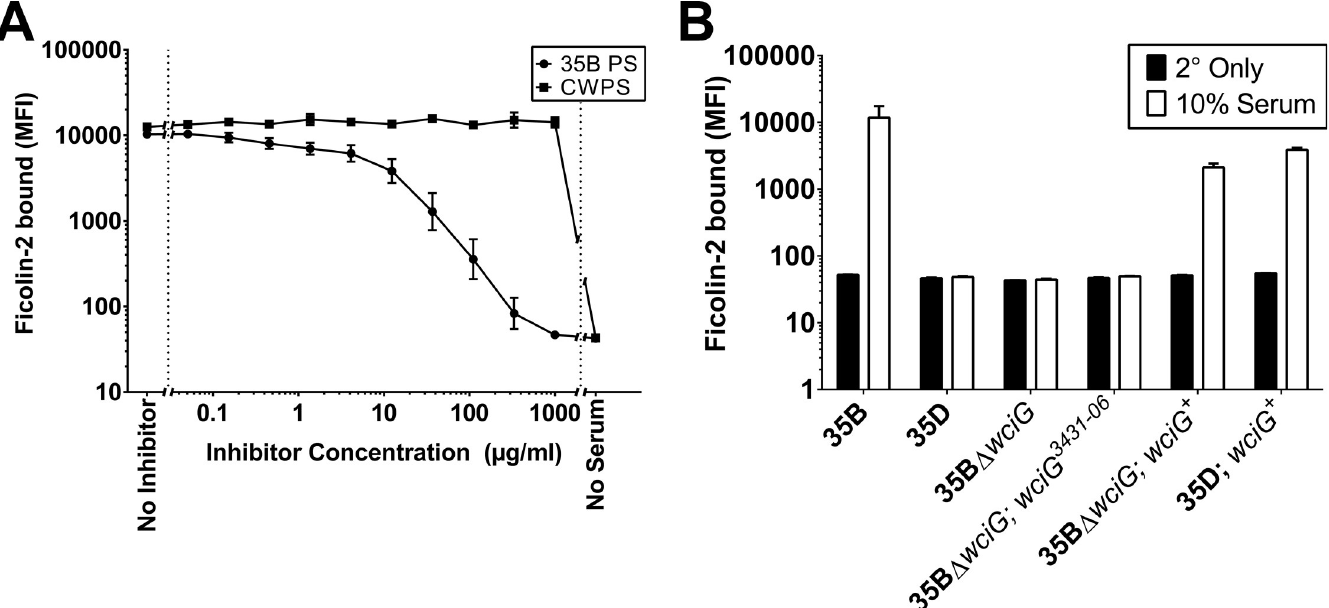
Fig 1. Ficolin-2 binds the serotype 35B capsular polysaccharide in a manner dependent on WciG-mediated O-acetylation. A, Serotype 35B strain 3009–06 was incubated with 10% normal human serum in the presence of increasing amounts of purified serotype 35B capsular polysaccharide (“35B PS”) or C-polysaccharide (“CWPS”) for 1 hour at 4˚C. After washing, bacteria were incubated with a ficolin-2-specific monoclonal antibody, washed, and incubated with a phycoerythrin- conjugated secondary antibody prior to washing and analysis via flow cytometry. B, Serotype 35B strain 3009–06 (“35B”) and serotype 35D strain 3431–06 (“35D”), along with their derivatives KAG1014 (“35B Δ wciG ”); KAG1019 (“35B Δ wciG; wciG 3431-06 ” ); KAG1023 (“35B Δ wciG ; wciG + ); and KAG1022 (“35D; wciG + ); were incubated with 10% serum at 4˚C for 1 hour prior to detection of ficolin-2 as above (“10% Serum”). In half of wells, the anti-ficolin-2 antibody was omitted (“2˚ Only”). Data are presented as mean ± standard deviation for two technical replicates and representative of at least three independent experiments.